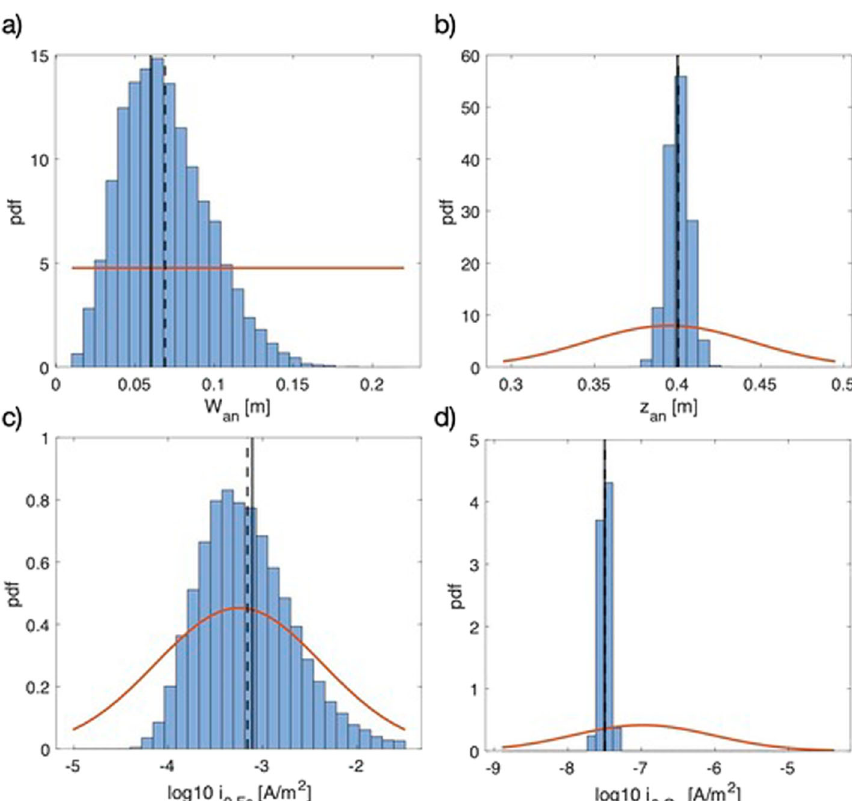
Fig. 3 Markov chain Monte Carlo (MCMC) sampling results for simulations with M = 9. The blue histograms show the probability density (pdf) function estimates of the MCMC results. The red curves are the corresponding prior probability densities for a W an , b z an , c log10( i 0,Fe ), d log 10( i 0 , O2 ). The vertical lines represent the known ground truth value, the dashed lines the mean of the MCMC